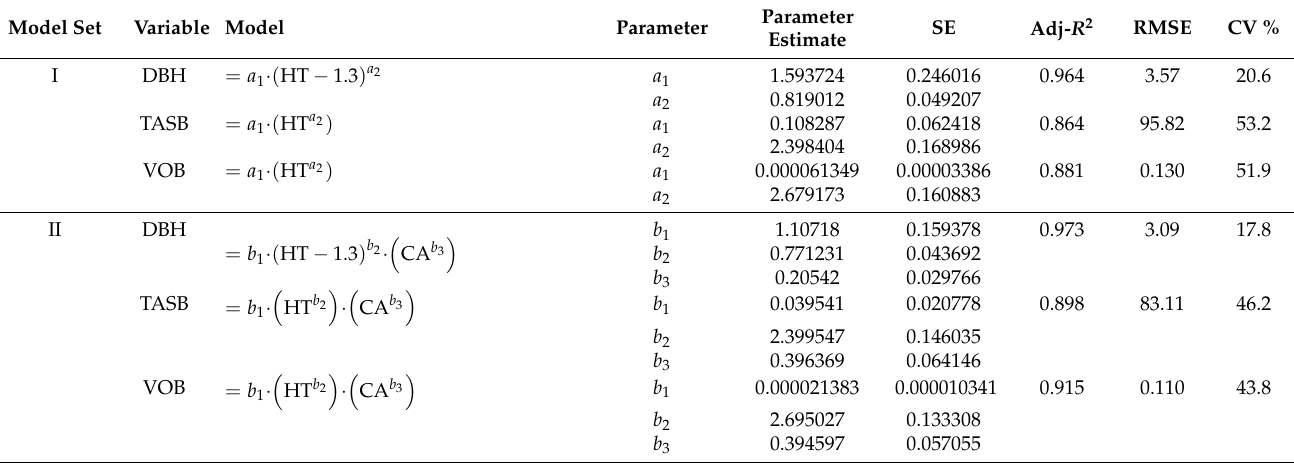
Table 3. Parameter estimates and fit statistics of the selected general DBH/biomass/volume functions for E. nitens trees growing in Central